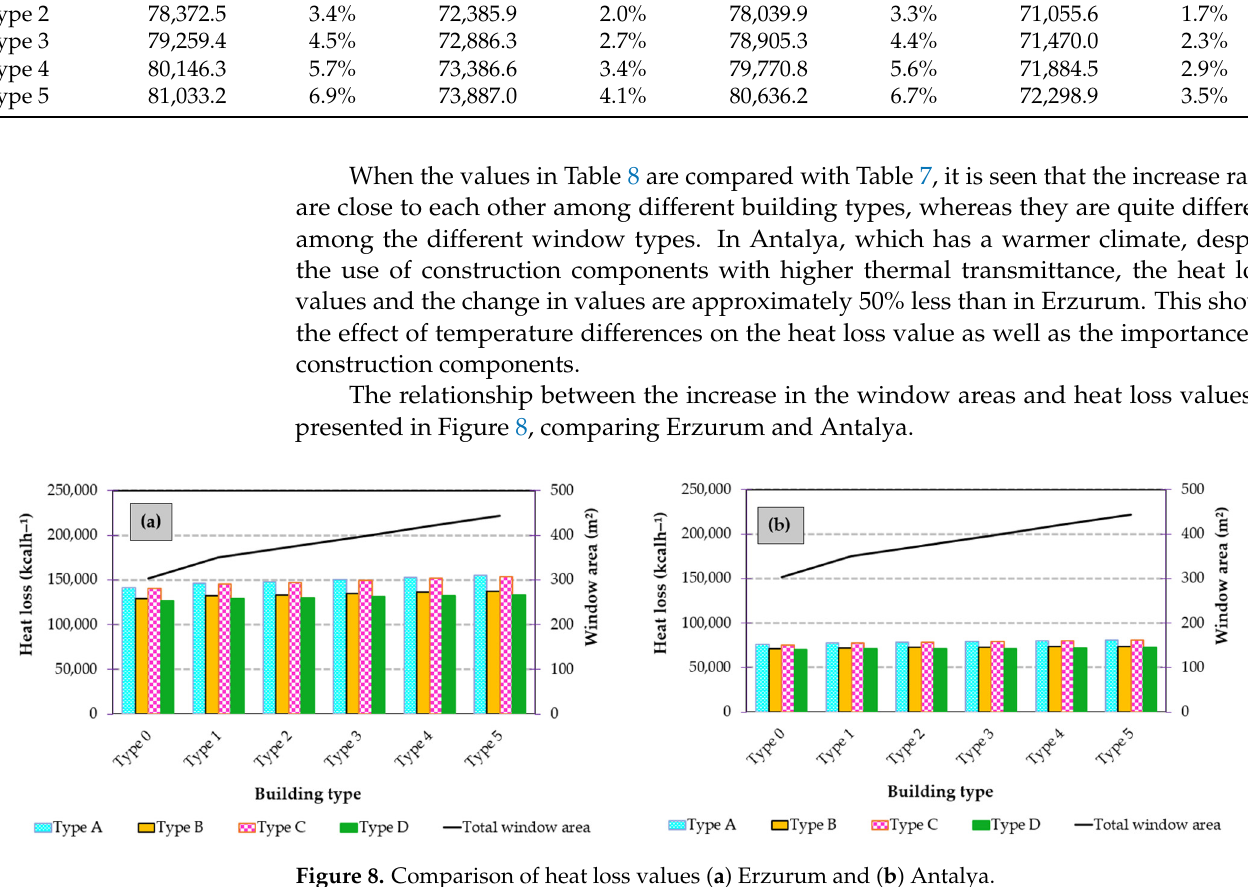
Figure 8. Comparison of heat loss values ( a ) Erzurum and ( b ) Antalya.